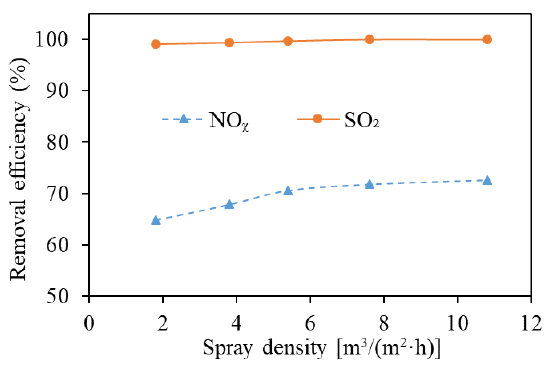
Figure 7. Effects of spray density on desulfurization and denitration efficiency levels (operating conditions: discharge power = 19.5 W, gas flow rate = 5 L/min, scrubbing solution = 1% NaOH solution, packing type = D g 6 mm Dixon ring, packing height = 80 cm).